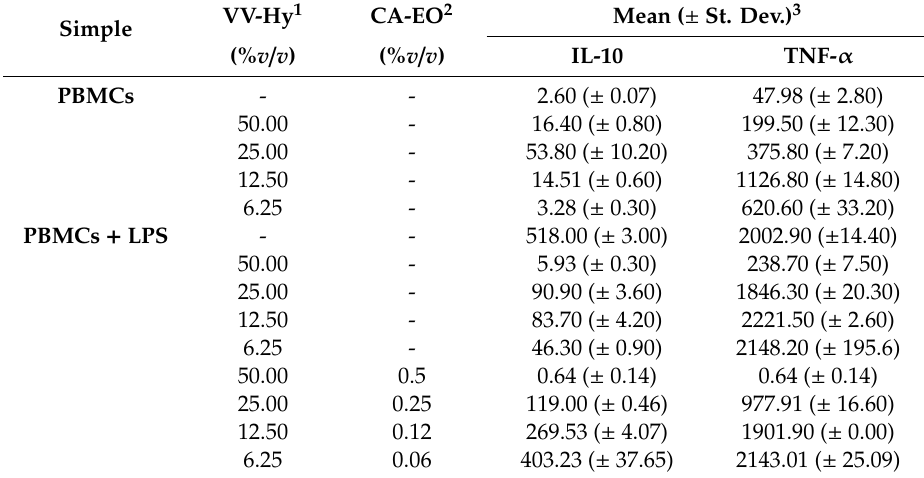
Table 3. IL-10 and TNF- α values of both peripheral blood mononuclear cells (PBMCs) and PBMCs stimulated with lipopolysaccharide (LPS) when treated with the Hy of V. vinifera alone or in combination with the EO of C. aurantium var. amara